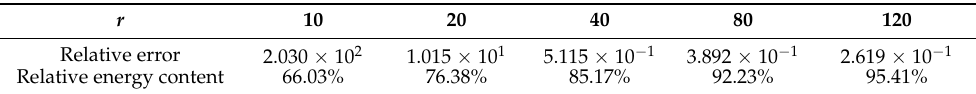
Table 3. Resolved, predictive regime. Relative L 2 errors (36) of the time-averaged streamfunction and relative energy content (30) for Galerkin ROM (G-ROM) with different r values.